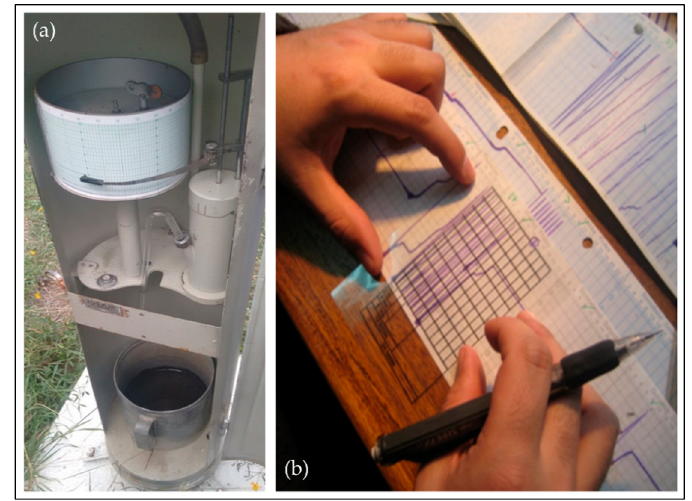
Figure 1. ( a ) A typical float-based pluviograph used in Chile; ( b ) observational procedure to recording rainfall intensities.